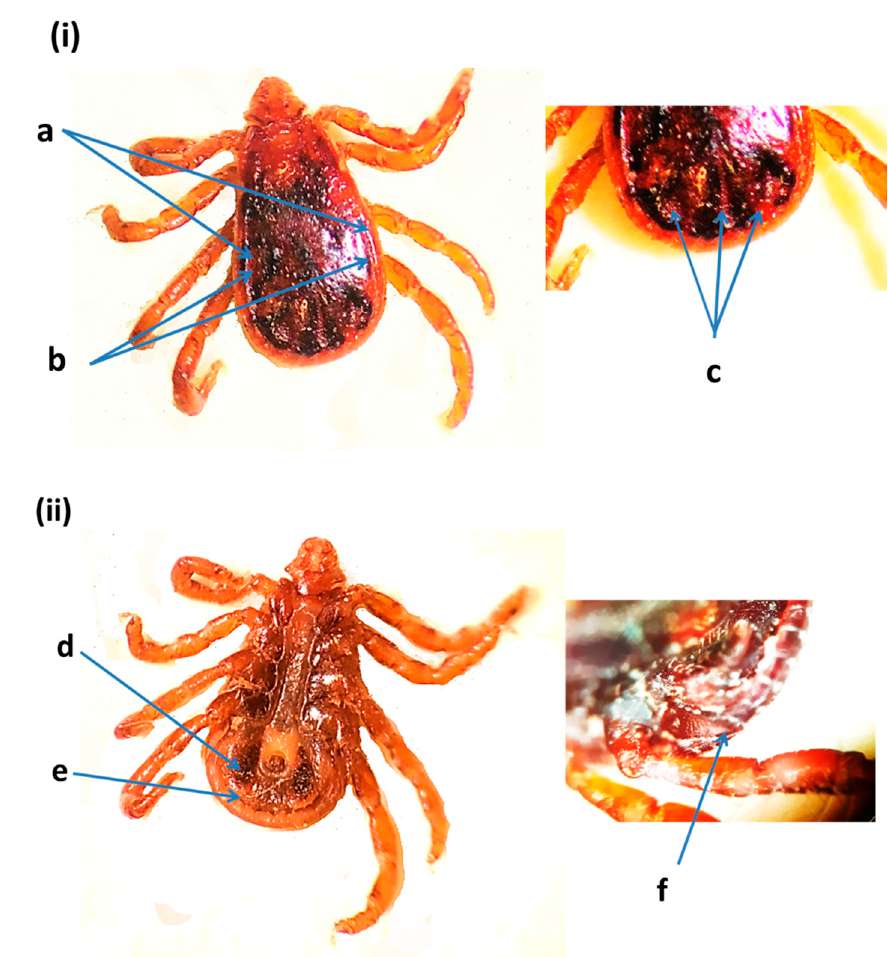
Figure 5. Rhipicephalus sanguineus male from the United Arab Emirates: ( i ) dorsal view: (a) marginal lines, (b) marginal lines anteriorly almost to eye level, (c) posterior grooves (comma shaped); ( ii ) ventral view: (d) adanal plates, (e) subadanal plates absent, (f) spiracle plate [11,29]. Table 2. Identity of tick species and percentage similarity value with the reference sequences from the GenBank. Sample Accession